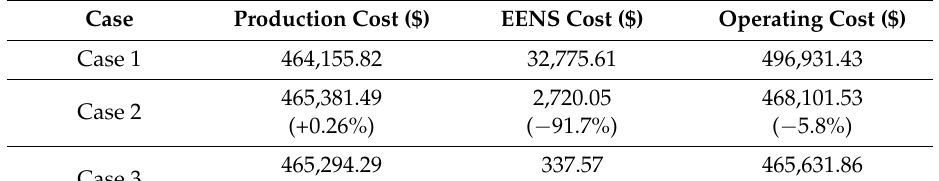
Table 5. Expected operating costs with DAUC.